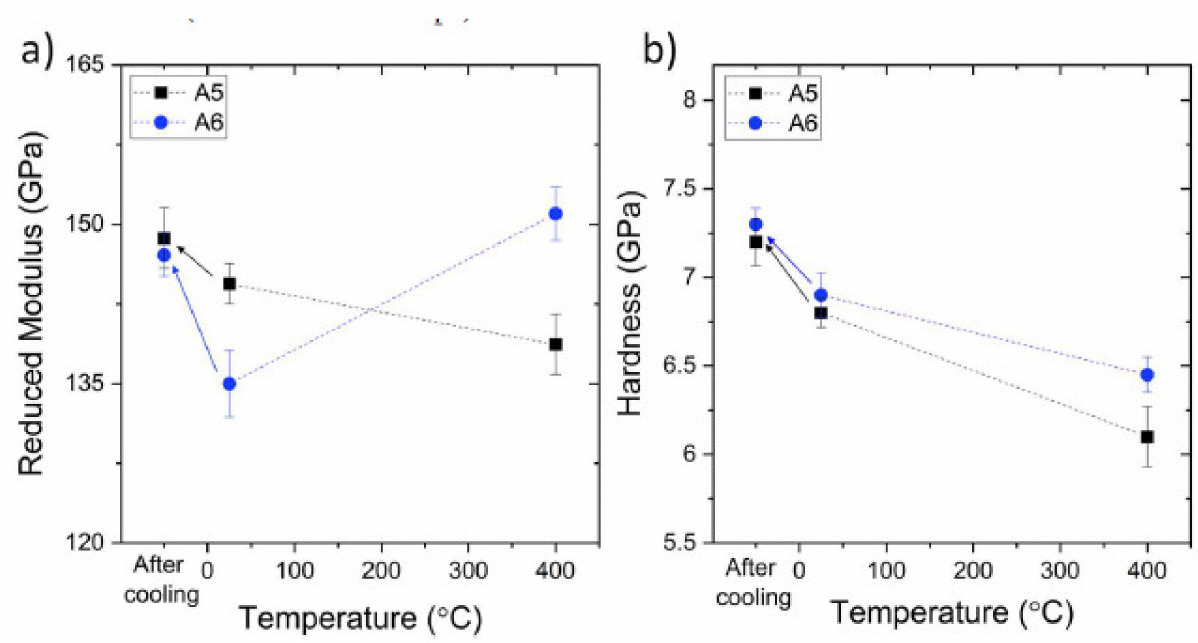
Figure 7. ( a ) Reduced modulus and ( b ) hardness of SPS samples A5 and A6 sintered at 100 K/min as the heating rate calculated with nanoindentation at RT and 400 ◦